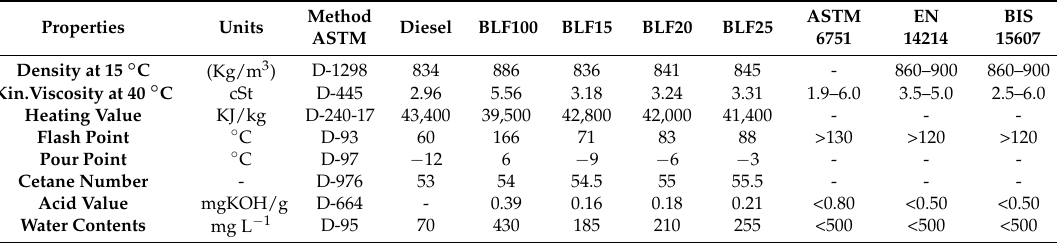
Table 4. Fuel properties of diesel, BLF, and its